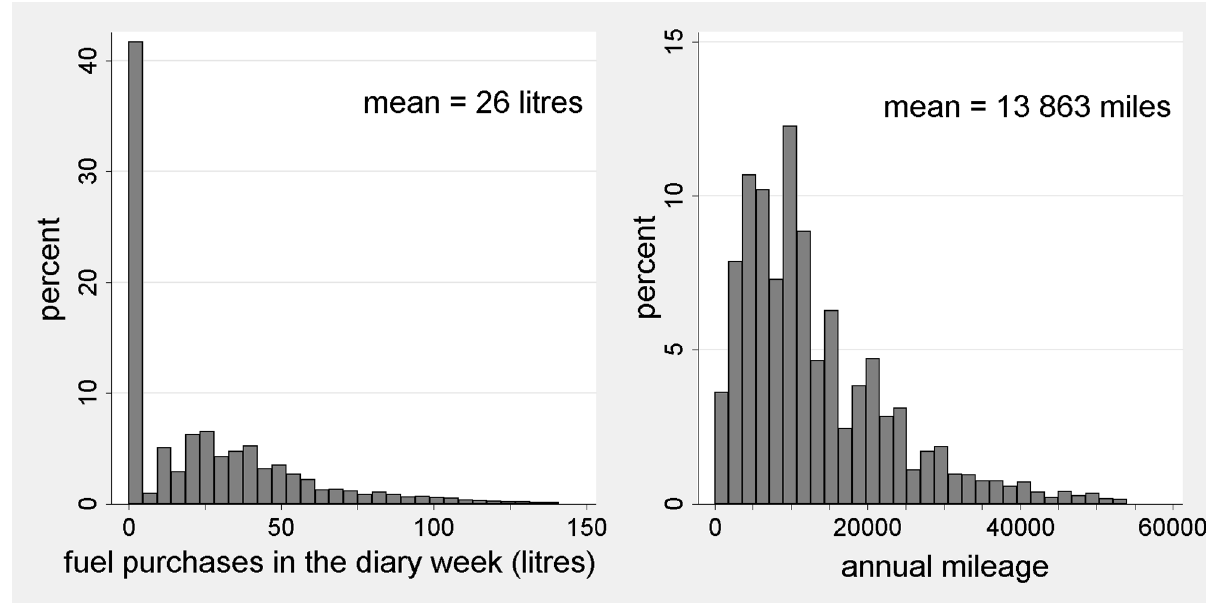
Fig 1. Sample distributions of motorist households’ fuel purchases and mileage, NTS 2002–2008. Notes: 1. The NTS reports mileageseparatelyfor each vehicle. The figure is obtained by aggregatingover vehicles. 2. Censoredat the 99 th percentile.